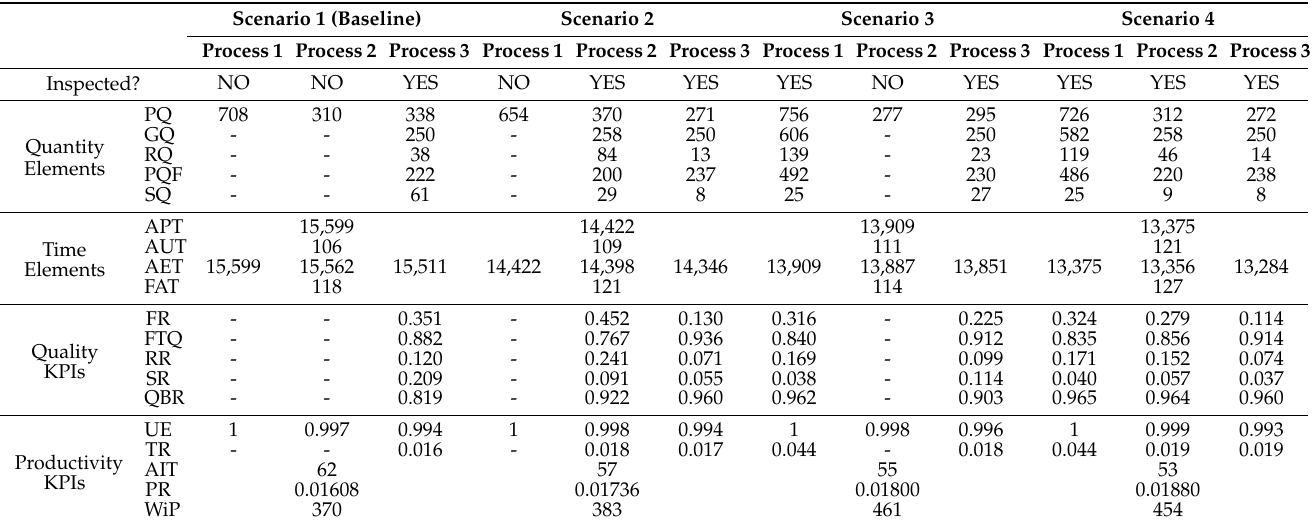
Table 3. Simulation results for different inspection strategies with set production